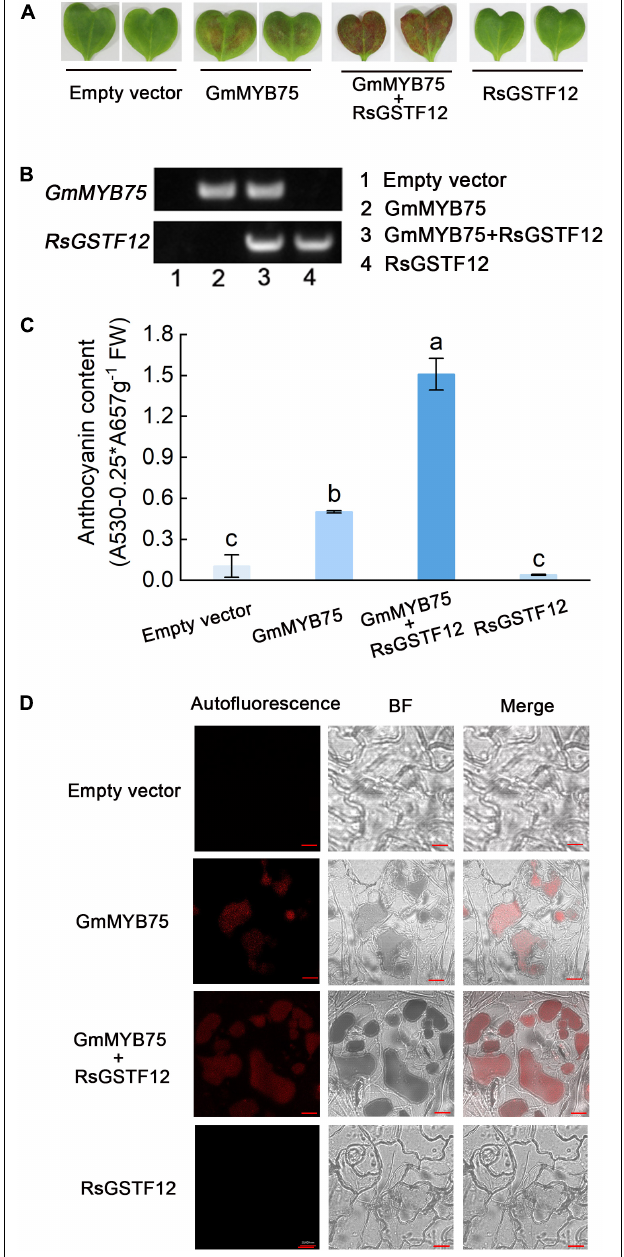
FIGURE 5 | RsGSTF12 increases anthocyanin sequestration in radish cotyledons. (A) Phenotypes and (C) anthocyanin content of radish cotyledons at 10 days since their injection with the empty vector, GmMYB75, GmMYB75 + RsGSTF12, or RsGSTF12. (B) The verification of RsGSTF12 or GmMYB75 was transferred into radish cotyledon. The upper and the lower bands, respectively, represent whether GmMYB75 or RsGSTF12 was transformed in empty vector (1), GmMYB75 (2), GmMYB75 + RsGSTF12 (3), and RsGSTF12 (4) treatments successfully. (D) Anthocyanin visualization in epidermal cells of radish cotyledons when expressed with an empty vector, GmMYB75, GmMYB75 + RsGSTF12, or RsGSTF12. Scale bar = 20 nm. Data in panel (C) are presented as the mean ± standard deviation (SD) whose significant differences are indicated by differing lowercase letters according to the Duncan’s multiple range test ( p <